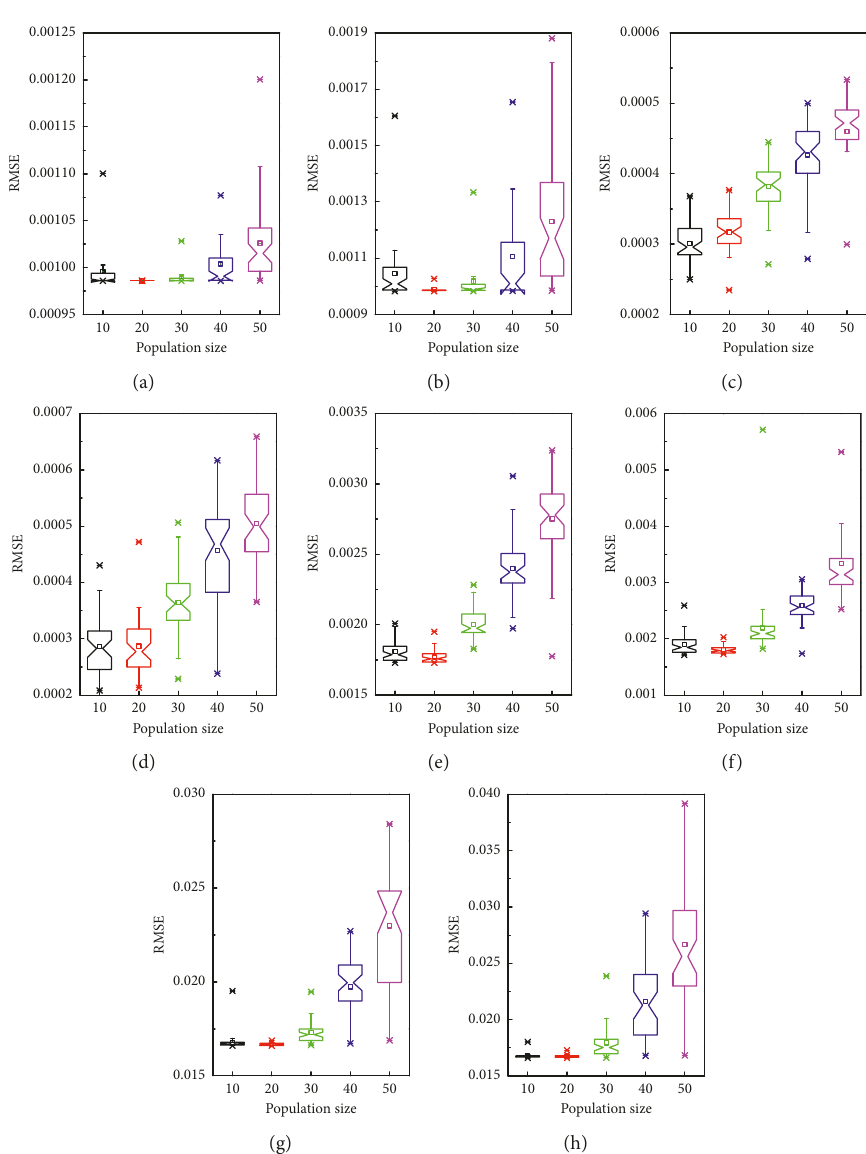
Figure 14: Influence of population size on SDO. (a) RTC France silicon solar cell with the SDM; (b) RTC France silicon solar cell with DDM; (c) PVM 752 GaAs thin film cell with the SDM; (d) PVM 752 GaAs thin film cell with the DDM; (e) STM6-40/36 monocrystalline module with the SDM; (f) STM6-40/36 monocrystalline module with the DDM; (g) STP6-120/36 polycrystalline module with the SDM; (h) STP6- 120/36 polycrystalline module with the